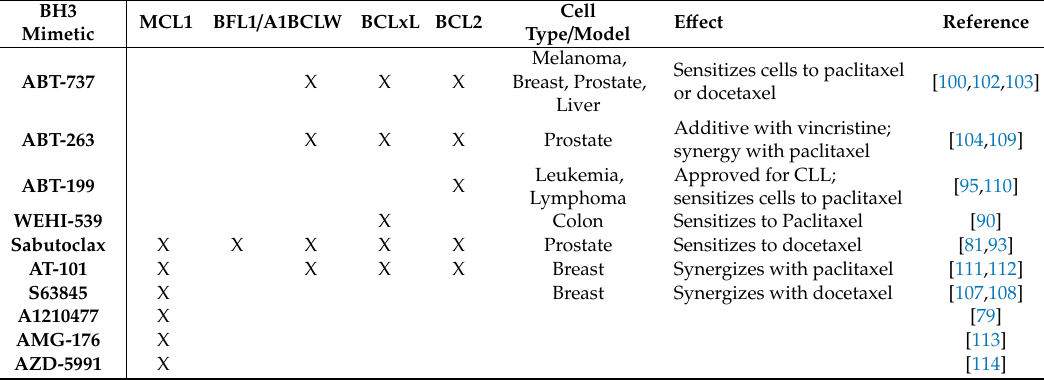
Table 2. BCL2 family inhibitors and their e ff ect in combination with